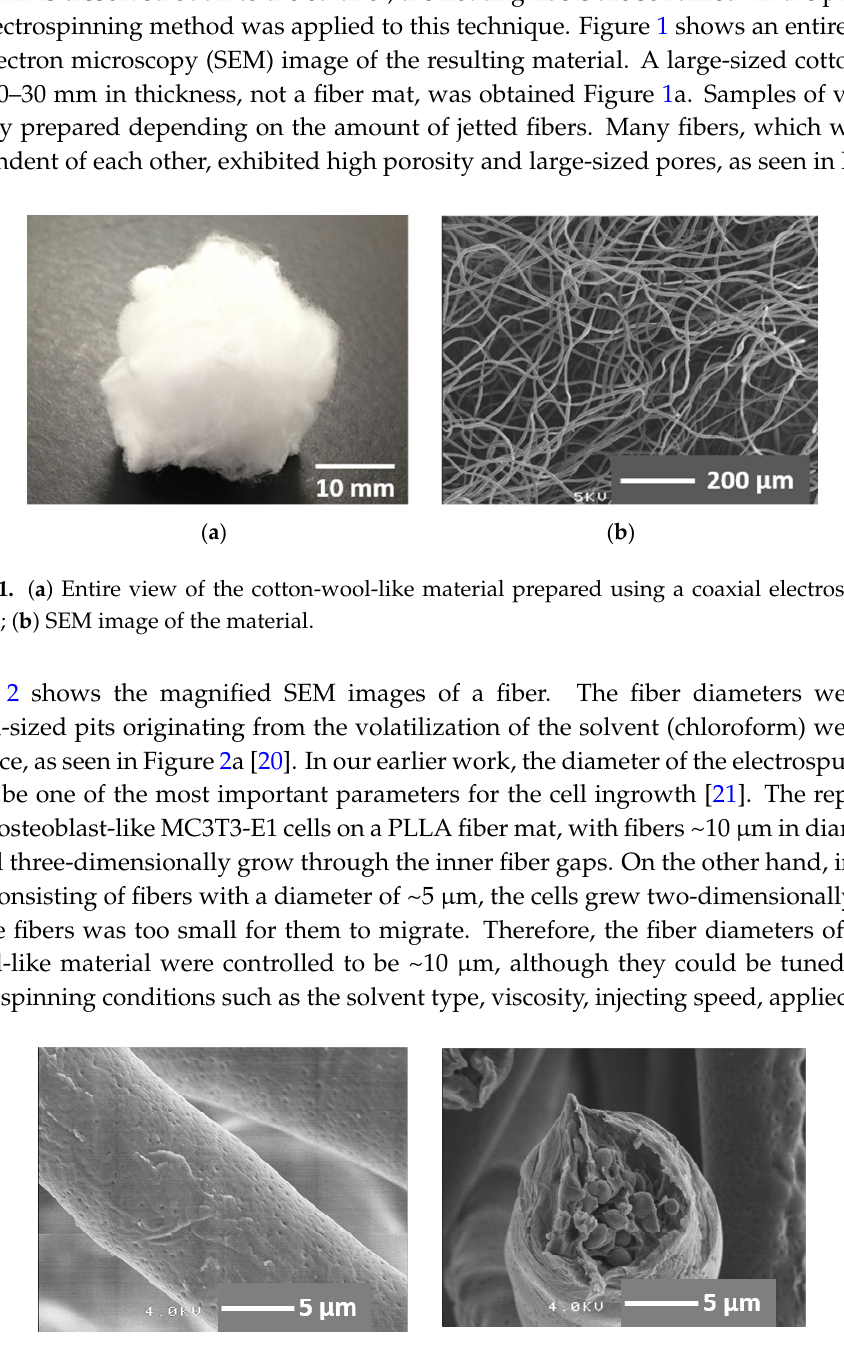
Figure 2. SEM images of the resulting fibrous material fabricated using a coaxial electrospinning method: ( a ) surface of the fiber; ( b ) fracture face after breaking the fiber in liquid nitrogen.